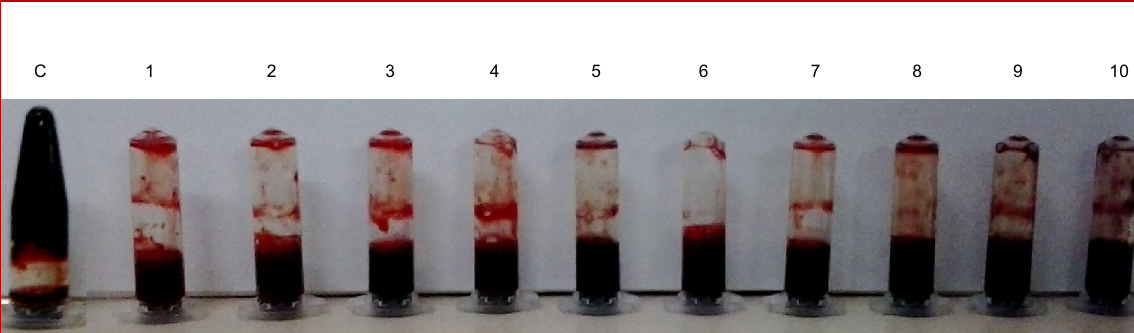
Figure 8: Holmstorm Method for Bacillus sp SFN mutated (10 min) precipitates in production media with shrimp shell (1 to 10